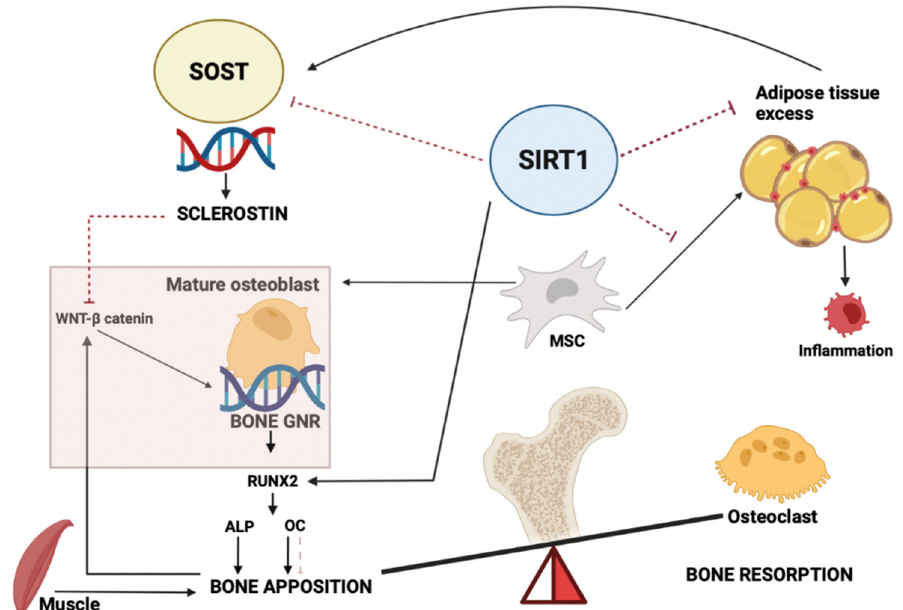
Figure 3. Effects of SIRT1 and sclerostin on bone. SIRT1 can determine the fate of mesenchymal stem cells by promoting osteogenic differentiation and suppressing adipogenic differentiation. SOST/sclerostin expression is controlled by epigenetic modifications and transcriptional regulation induced by SIRT1. Abbreviations: SIRT1, sirtuin 1; GNR, genetic regulatory network; RUNX2, runt-related transcription factor 2; ALP, alkaline phosphatase; OC, osteocalcin; MSC, mesenchymal stem cells.